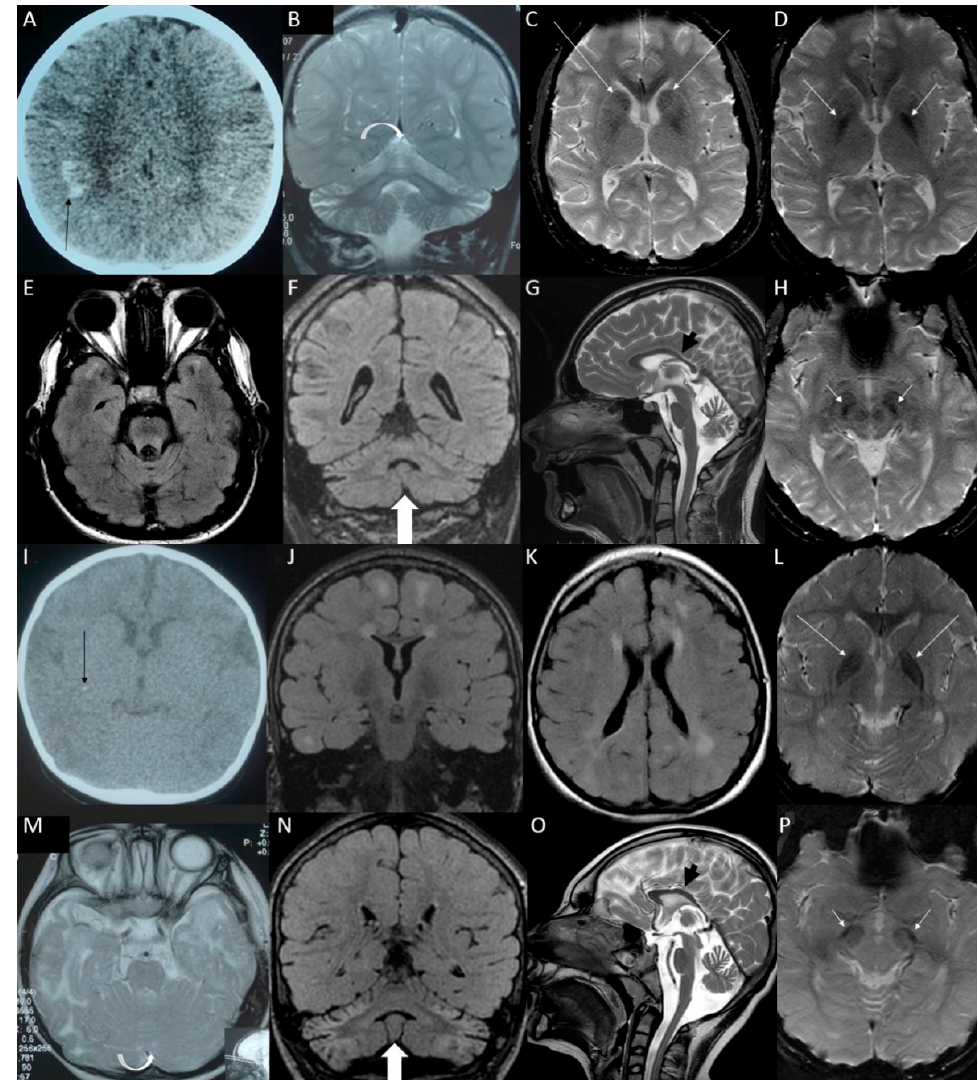
Figure 1. Brain imaging of sibling with SUPV3L1 homozygous variant c.1093C>T:p.(Arg365Trp)—the older brother (patient S19a) in panels. ( A ) Computed tomography (CT) at the early childhood with marked subcortical calcifications in both frontal and parietal lobes (black arrow). ( B ) Subsequent magnetic resonance imaging (MRI) scans at the middle childhood with marked shrunken bright cerebellum (white arrow). ( C – H ) Brain MRI at the late adolescence. ( E ) FLAIR hyperintensities remained in the temporal poles only, ( F ) atrophic cerebellum but not so FLAIR-hyperintense as earlier and as in the younger sister (white arrow), ( G ) the corpus callosum is shorter and thinner than normal (black arrow), ( D ) iron or calcium deposits in the globi pallidi (white arrows), ( H ) in substantia nigra (white arrows) ( C ) and in the caudate nuclei (white arrows); brain imaging of sibling with SUPV3L1 homozygous variant c.1093C>T:p.(Arg365Trp)—the younger sister (patient S19b): ( I ) CT at the early childhood revealed two punctate subcortical calcifications in the right cerebral hemisphere (black arrow). ( M ) MRI taken as the toddler with normal cerebellum with slight widening of the cerebellar sulci (white arrow). ( J – P ) MRI at the early adolescence: ( J , K ) myelination has progressed, but there are white matter hyperintensities on FLAIR sequence in both cerebral hemispheres, ( N ) shrunken bright cerebellum (white arrow), ( O ) shortened and thinned corpus callosum (black arrow), ( L ) iron or calcium deposits in the globi pallidi (white arrows) ( P ) and in substantia nigra (white